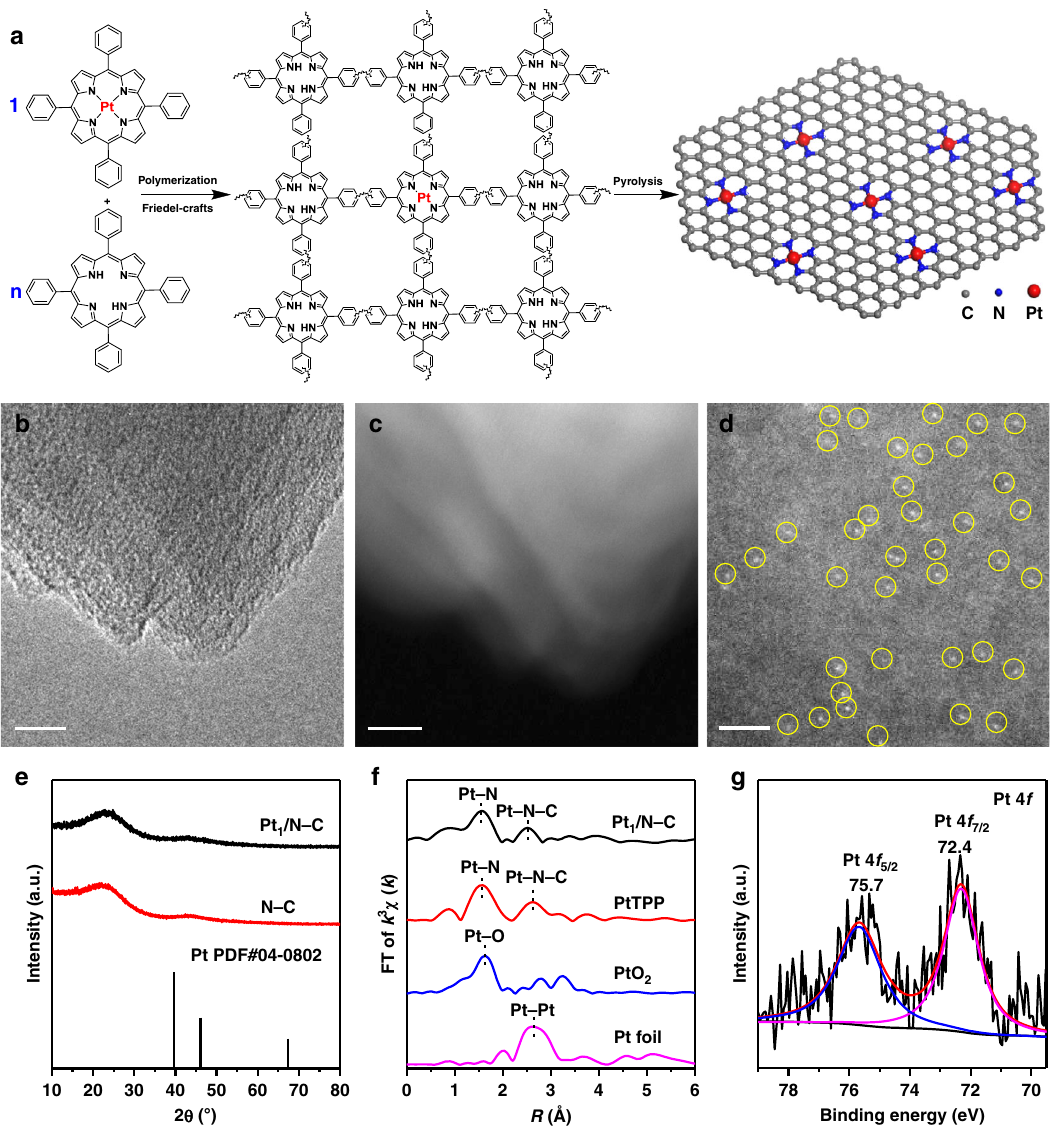
Fig. 1 Preparation and structural characterization of Pt 1 /N – C. a Schematic illustration of the preparation of Pt 1 /N – C. The molar ratio of PtTPP:TPP is denoted as 1:n. b TEM image of Pt 1 /N – C. Scale bar, 10 nm. c STEM image of Pt 1 /N – C. Scale bar, 10 nm. d AC HAADF-STEM image of Pt 1 /N – C. SAs were highlighted by yellow circles. Scale bar, 2 nm. e XRD pattern of Pt 1 /N – C and N – C. f The k 3 -weighted R-space FT spectra of EXAFS for Pt 1 /N – C, PtTPP, PtO 2 , and Pt foil. g The XPS patterns of Pt 4 f for Pt 1 /N –